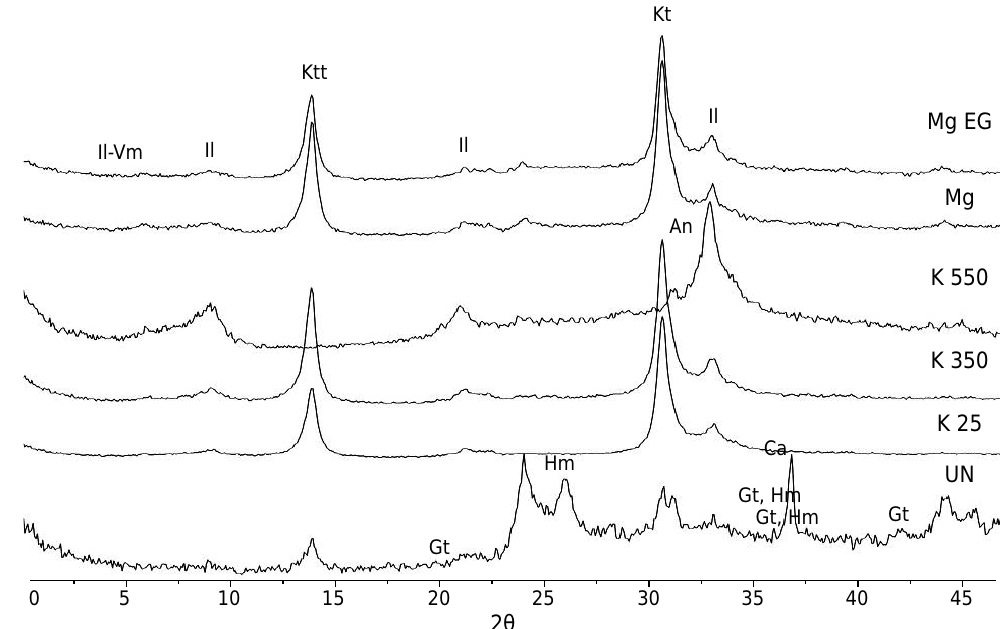
Figure 5. Diffractograms of the clay fraction of soil horizons in profile 4 (P4). Illite (Il), Kaolinite (Kt), Goethite (Gt), Vermiculite (Vm), Anatase (An). Untreated total sample (UN), iron-free sample saturated with magnesium (Mg) and solvated with magnesium and ethylene-glycol (MgEG), iron free sample saturated with potassium at room temperature (K25), and after heating at 350 °C (K350) and 550 °C